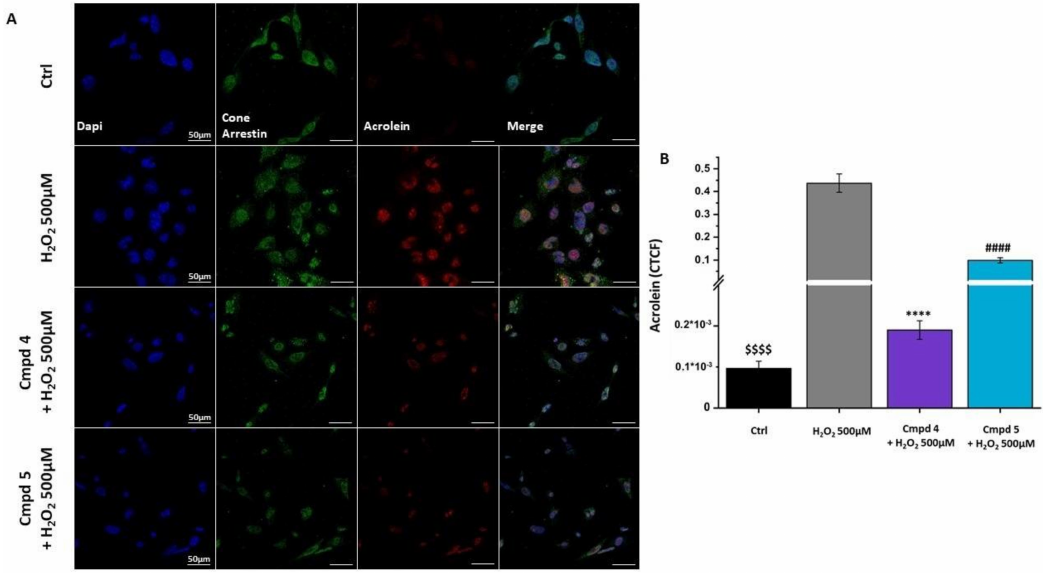
Figure 6. Treatment with 4 or 5 decreases the expression of oxidative stress biomarker in 661W cell line. ( A ) Immunofluorescence detection of cone arrestin (green) and acrolein (red) in cells pre- treated with compounds 4 or 5 for 24 h at the chosen concentration of 100 µ M and then exposed for 3 h to H 2 O 2 500 µ M. Nuclei were counterstained with DAPI. (Ctrl: control group, no compounds or H 2 O 2 exposure). Scale bars = 50 µ m; ( B ) Corrected total cell fluorescence (CTCF) of acrolein in cell treated as indicated. Values in the graph indicate the CTCF of acrolein of cells as the mean ± SE, normalized with the H 2 O 2 500 µ M group (see Materials and Methods section for CTCF calculation); statistics: one-way ANOVA test followed by Levene’s post-test. $$$$ p ≤ 0.0001 (Ctrl vs. H 2 O 2 500 µ M); **** p ≤ 0.0001 ( 4 : 100 µ M vs. H 2 O 2 500 µ M); #### p ≤ 0.0001 ( 5 : 100 µ M vs. H 2 O 2 500 µ